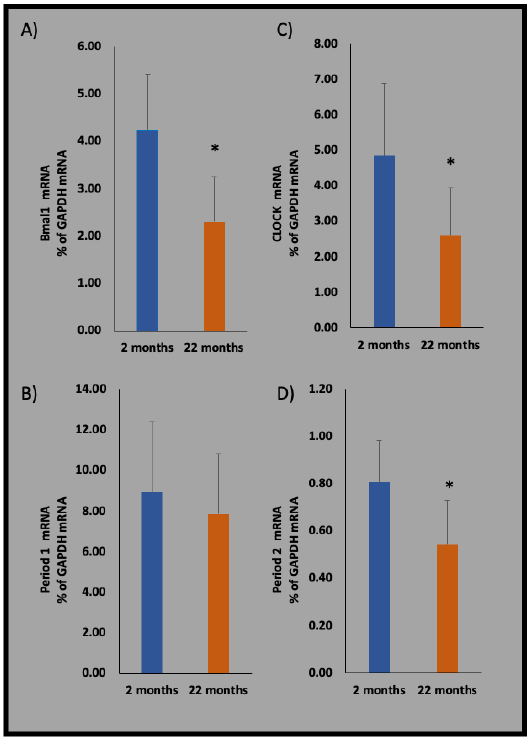
Figure 2. mRNA expression changes of: ( A ) BMAL1 , ( B ) PER1 , ( C ) CLOCK , and ( D ) PER2 in flow- sorted microglia in the prefrontal cortices of 2- and 22-month-old male Wistar rats (both n = 6). Samples were collected at ZT7. Microglia were sorted from the prefrontal cortex as we described previously [26]. RNA extraction and reverse transcription for quantitative polymerase chain reaction (qPCR) were conducted using a SuperPrep™ II Cell Lysis & RT Kit (Toyobo, Osaka, Japan). qPCR was performed as described previously [26]. The expression of clock genes was suppressed in senescent microglial cells. Data are expressed as mean ± standard deviation (SD). * p < 0.05, with unpaired two-tailed t -test.